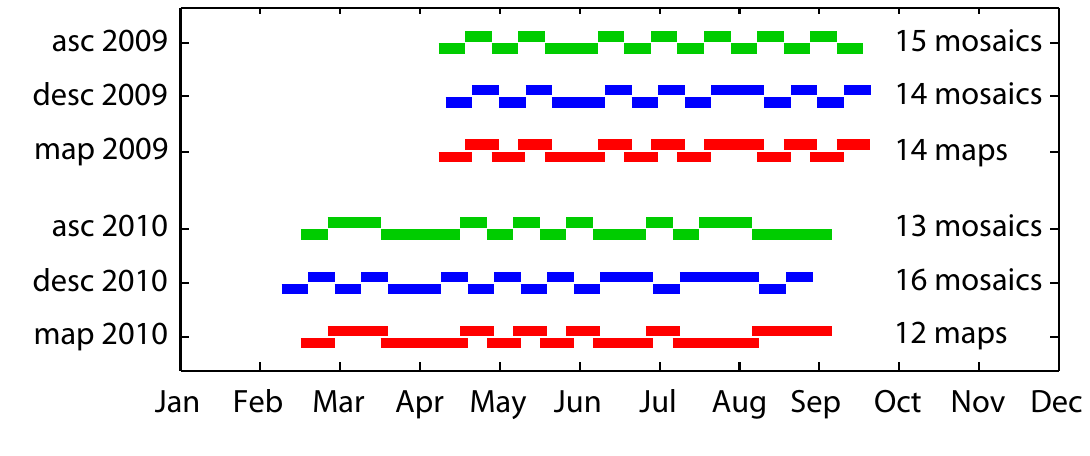
Figure 3. Timewise arrangement of the 116 processed image pairs for ascending (green) and descending (blue) orbits from 2009 and 2010. One bar represents one offset image derived from mosaicing two adjacent feature tracking results. During the decomposition, mosaics from both orbits are merged, resulting in a total of 26 displacement maps (red) available for the kinematic